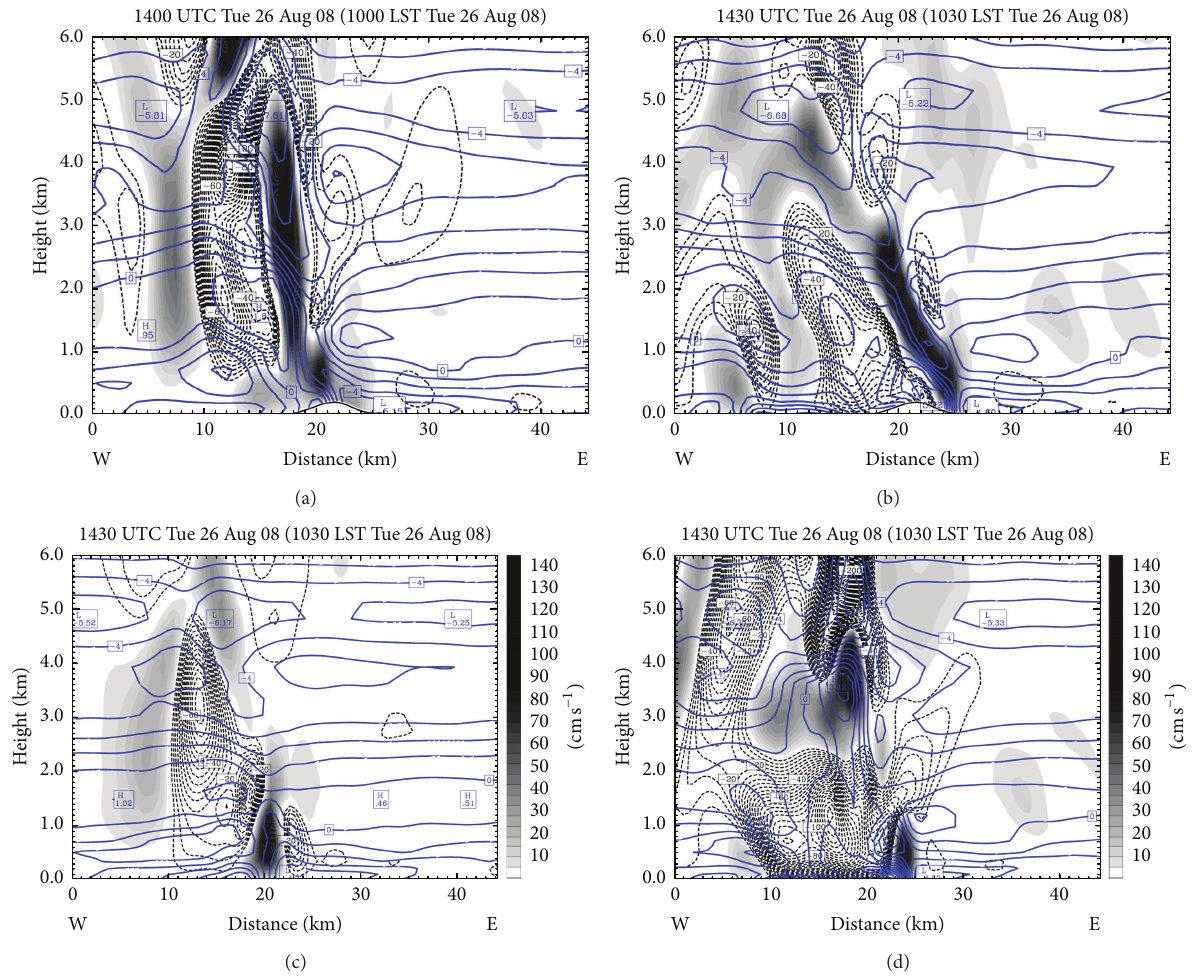
Figure 8: Cross-section BB 󸀠 for vertical velocity (shaded) and zonal winds for the CTRL experiment valid at (a) 1400UTC and (b) 1430UTC; (c) and (d) are the same but for the NOTER